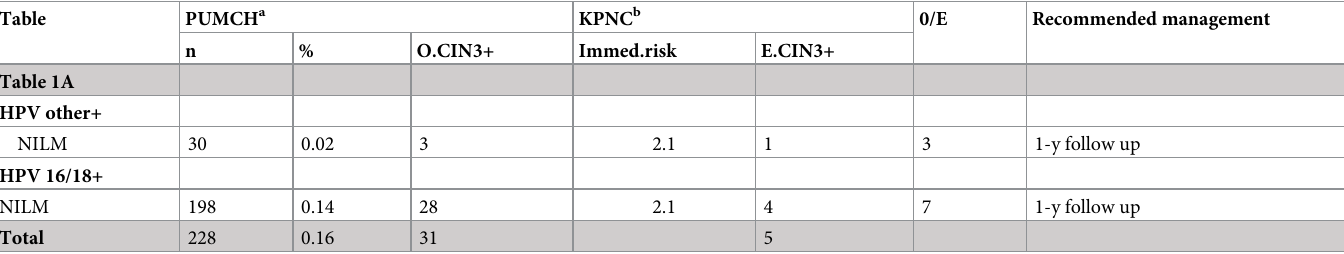
Note: PUMCH a corresponds to PUMCH data. KPNC b corresponds to risks and risk-based management according to KPNC cohort. The column named “table” represents the risk-based management tables used to assess the risk of CIN3+ from KPNC cohort in the 2019 ASCCP guidelines. “N” indicates number of observations of our data. The third column represents the percentage of observations among all 1404 patients in our study. “Immed.risk” is for immediate CIN3+ risk as estimated from KPNC; The column of “E.CIN3+” represents the expected patients of CIN3+ according to the immediate CIN3+ risk. The column of “O.CIN3+” represents the patients of CIN3+ observed in PUMCH data. O/E, observed/expected. the last column of “recommended management” represents the different management according to the KPNC-based management